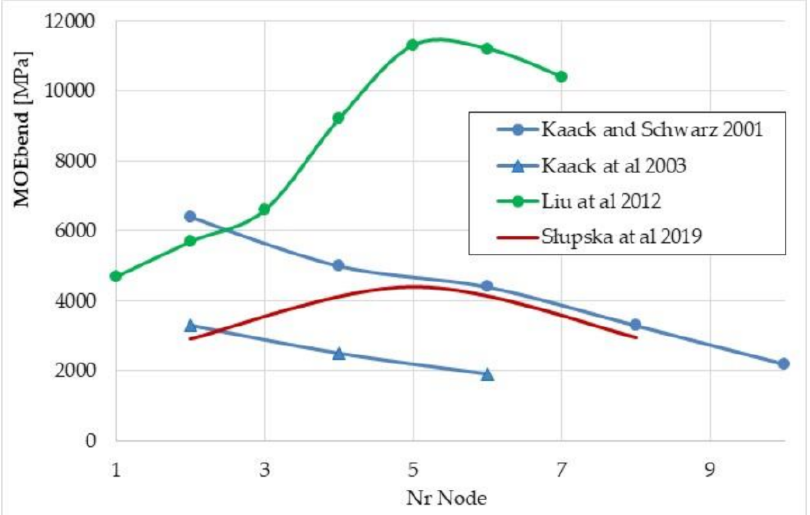
Figure 12. Changes in the value of modulus of elasticity in bending MOE bend depending on the number of the internode for the giant miscanthus: Kaack and Schwarz 2001 [48], Kaack et al., 2003 [49], Liu et al., 2012 [40], Słupska et al., 2019